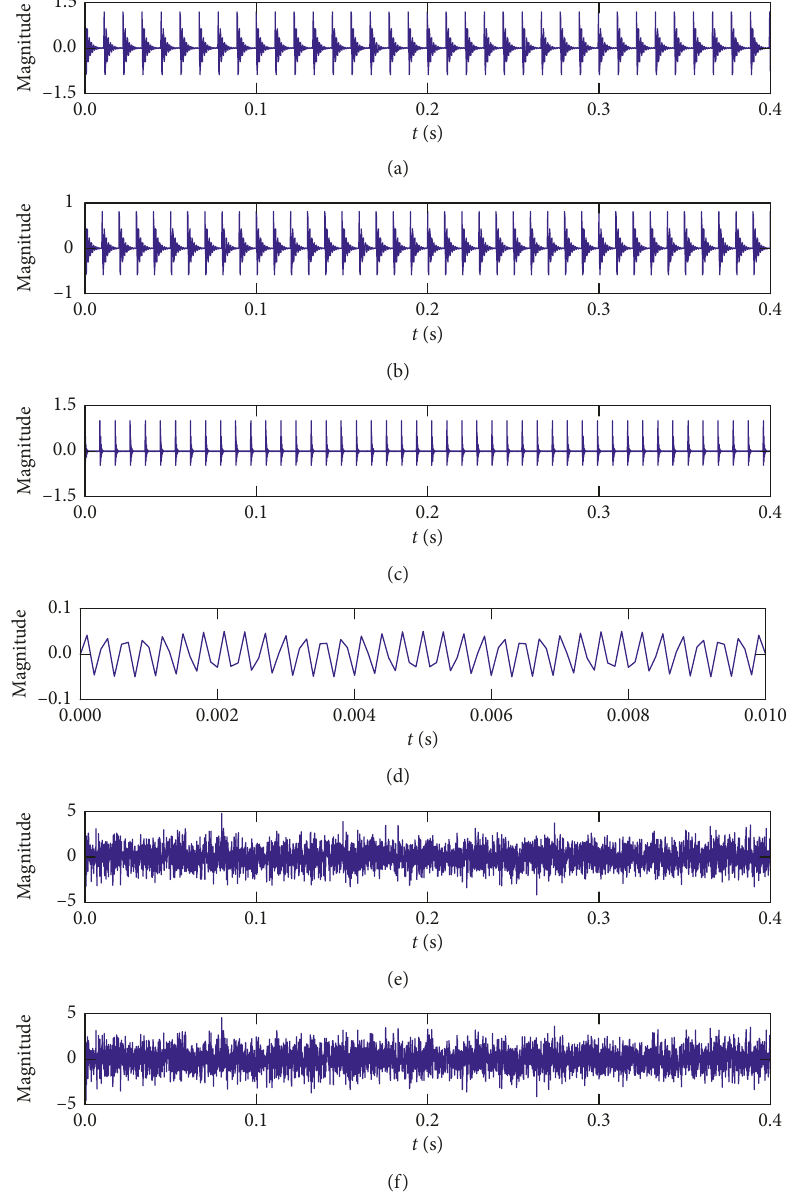
Figure 3: Simulation signals: (a) s